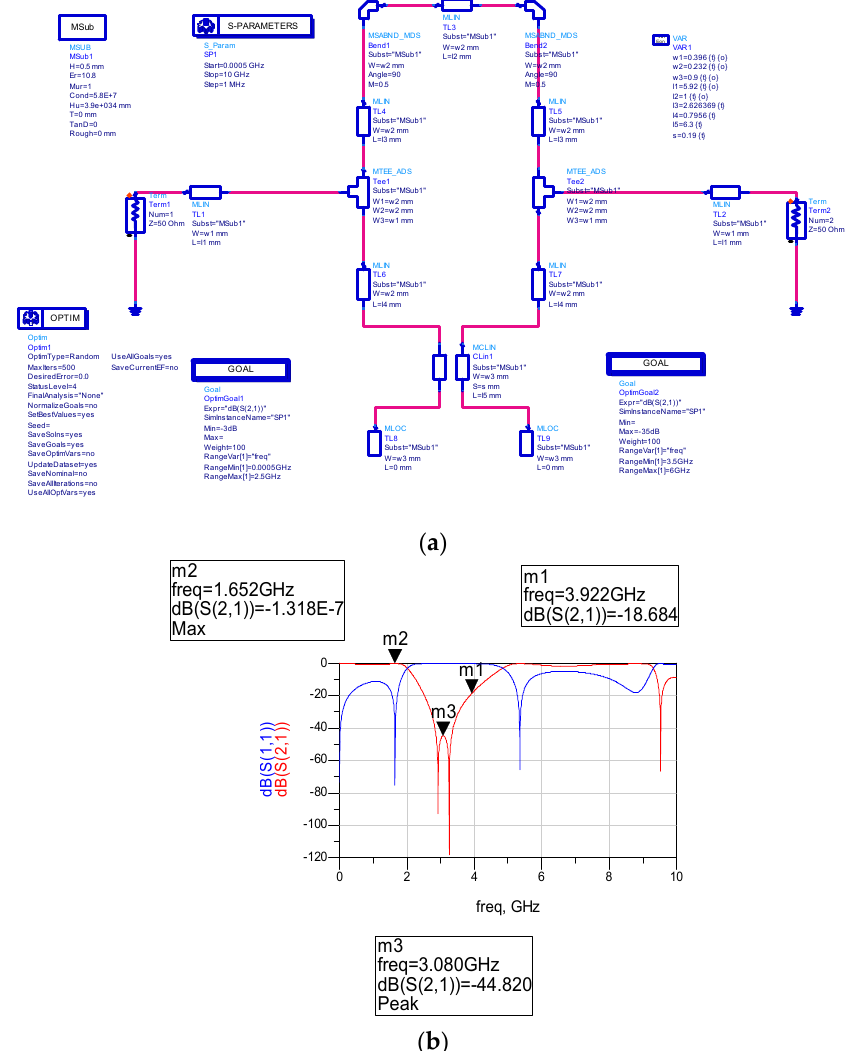
Figure 6. SIR hairpin LPF composed of single resonator with internal coupling. ( a ) The schematic diagram modeled in Agilent ADS software. ( b ) The simulation transmission characteristics.